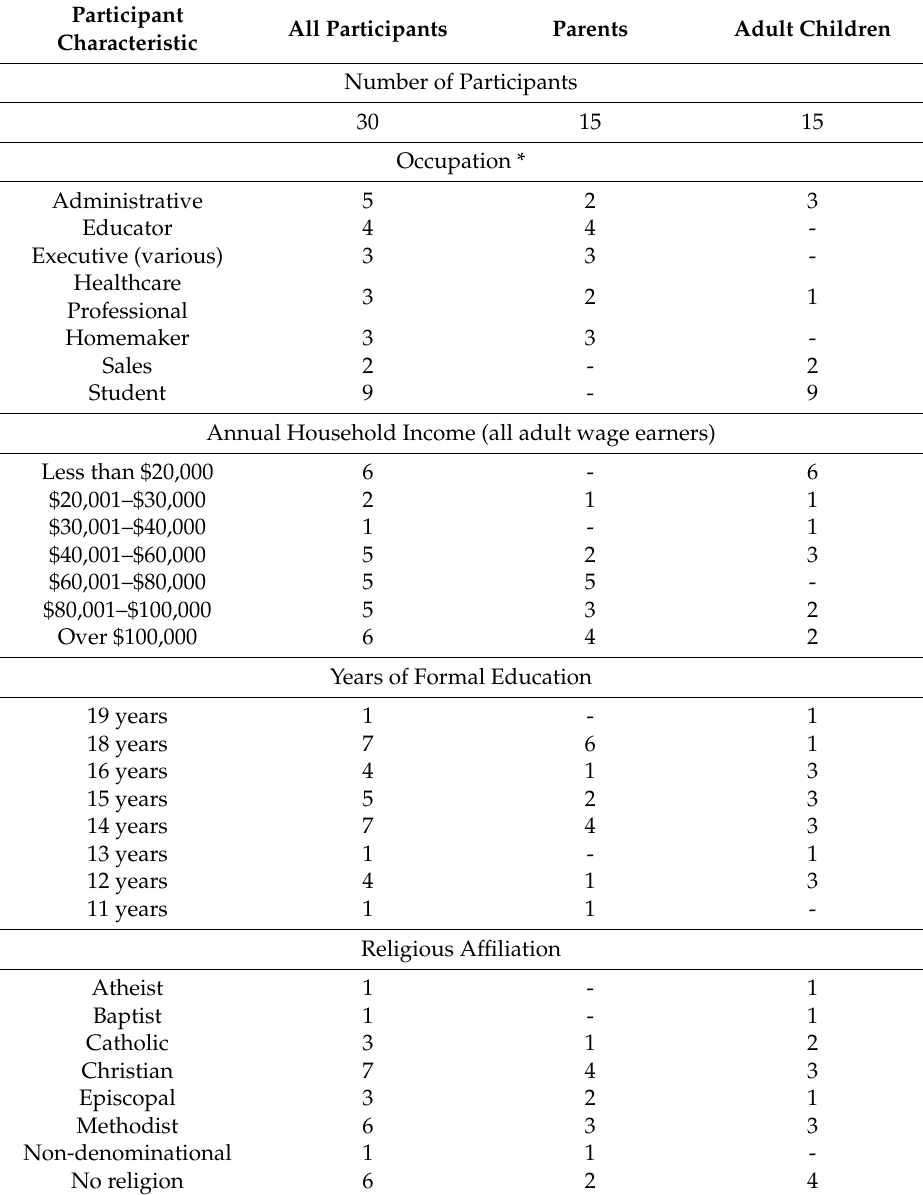
Table 2. Work and Related Sample